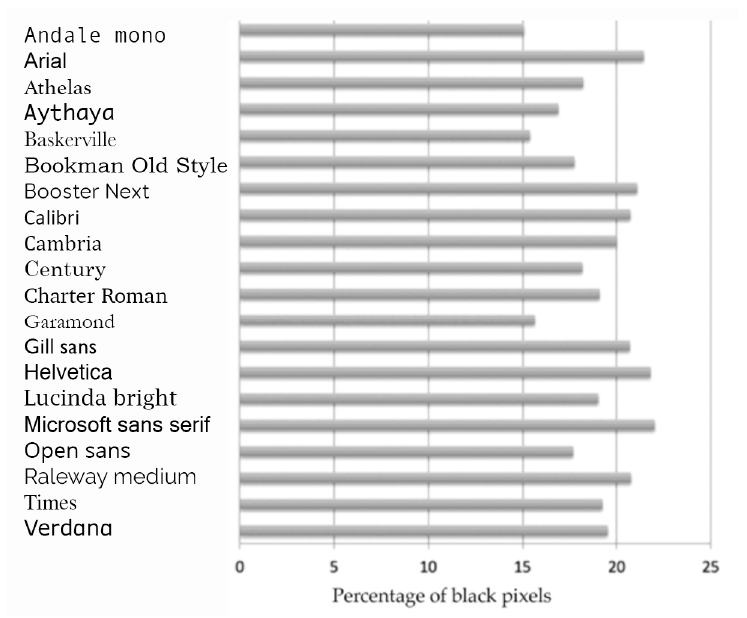
Figure 8. Weights of 20 fonts as estimated from the percentage of black pixels in a line of text. There was a moderate but significant correlation (r = 0.624, p = 0.003) between the algorithm output and the weight of the font as defined above, shown in Figure 9. The e ff ect of font weight on the algorithm can therefore be understood in terms of the contrast of the striped lines or “grating” formed by the lines of text.